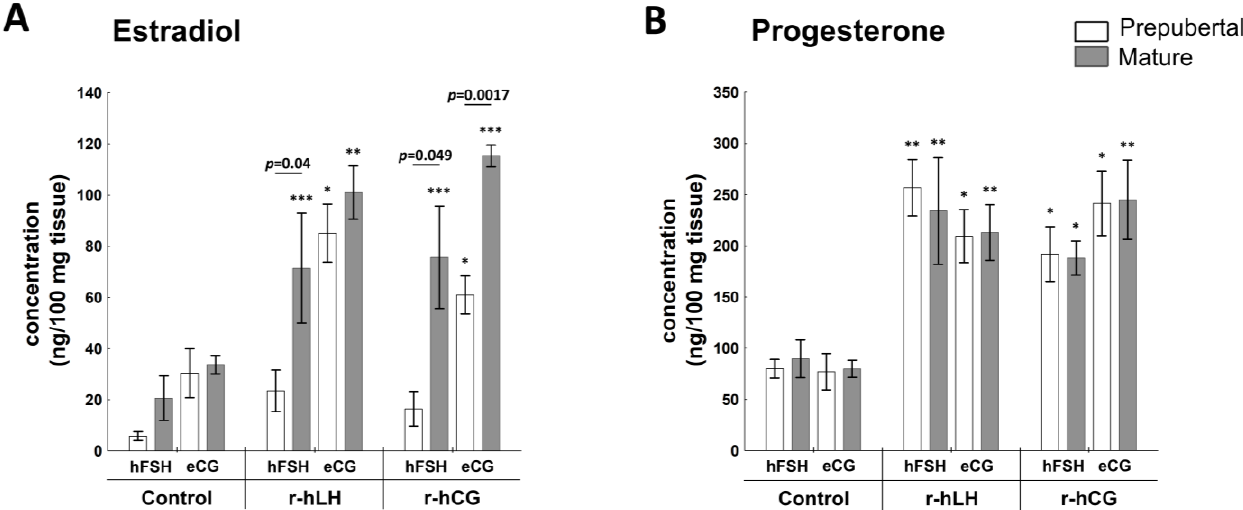
Figure 5. Hormonal response of the follicular walls to r-hLH and r-hCG treatment differs in pre- pubertal and mature gilts primed in vivo with hFSH or eCG. Secretion of E2 ( A ) and P4 ( B ) by r-hLH- and r-hCG-in vitro-stimulated follicular wall explants is shown for prepubertal and mature gilts primed in vivo with hFSH or eCG. Data were analyzed using one-way ANOVA with Tukey post-hoc tests and are presented as mean ± SEM (n = 6 per group); * p < 0.05; * * p < 0.001; ** * p < 0.0001 for control vs. r-hLH or r-hCG treatment. Line with a p -value denotes significant differences between prepubertal and mature